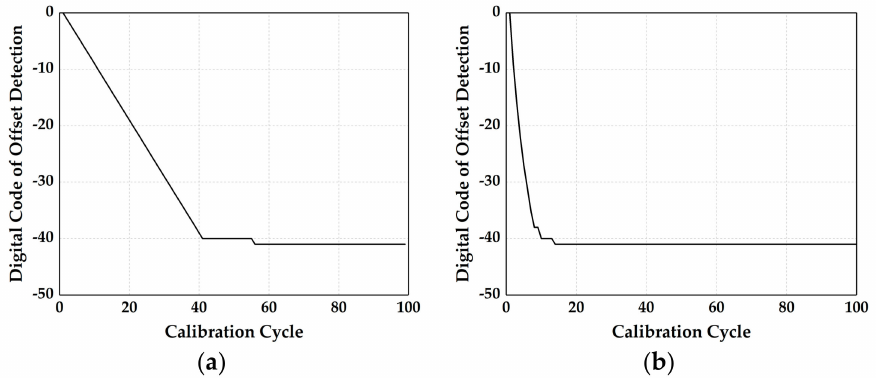
Figure 7. Simulated calibration convergence with ( a ) fixed step and ( b ) the proposed dynamic